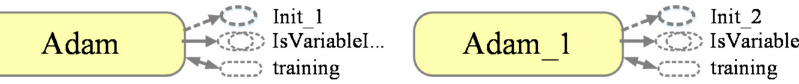
Figure 7. Adam optimizer in